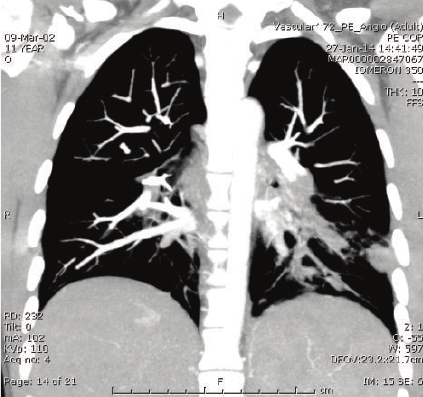
Figure 5: Septic emboli in the bilateral lower pulmonary